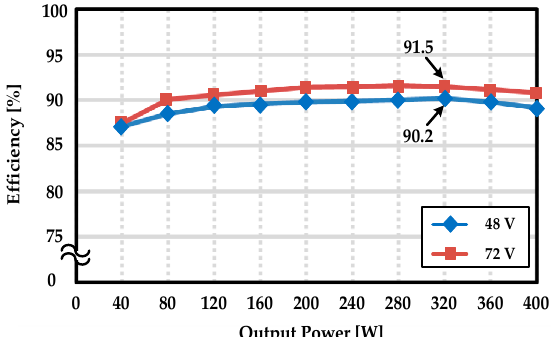
Figure 12. Measured efficiency curve of the active-clamp forward inverter. Table 4. Measured power factor, T.H.D. and odd-order harmonics of the output current during grid- connection mode.